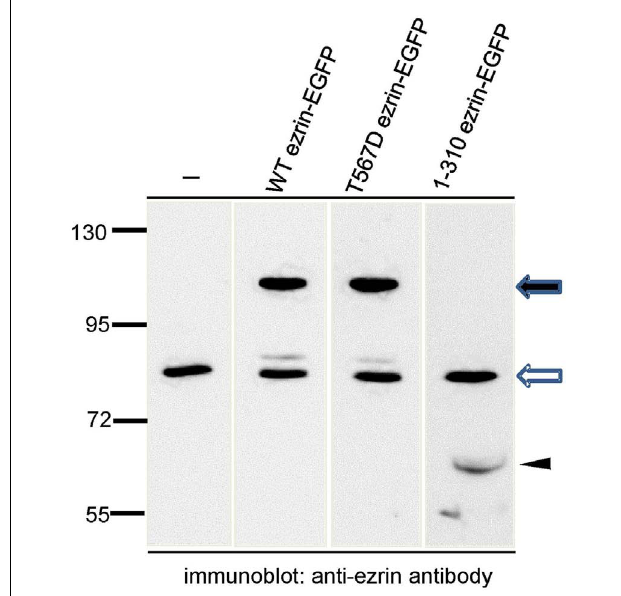
FIGURE 3 | Localization of tagged ezrin constructs in humanT cells, and impact of expression of ezrin constructs on cell morphology. (A–C) T-lymphocytes were transfected either with wild type (WT) ezrin-EGFP, T567D ezrin-EGFP, or 1–310 ezrin-EGFP. Four hours after transfection, cells were incubated in the absence or presence of SDF-1, as described in the legend of Figure 1D , followed by fixation with PFA and staining for β -cytoplasmic actin. Bar, 10 µ m. (A) Fluorescence pictures obtained by confocal microscopy; (B) quantitative evaluation of the % of transfectedT cells with capped EGFP-tagged wild type or mutant ezrin (mean ± SEM of three to five independent experiments); (C) quantitative evaluation of the % of transfectedT cells with front-tail polarity (mean ± SEM of three to four experiments; exception: EGFP: n = 2). (B,C) * P < 0.05; ** P < 0.01; *** P < 0.001 for statistically significant differences between data as